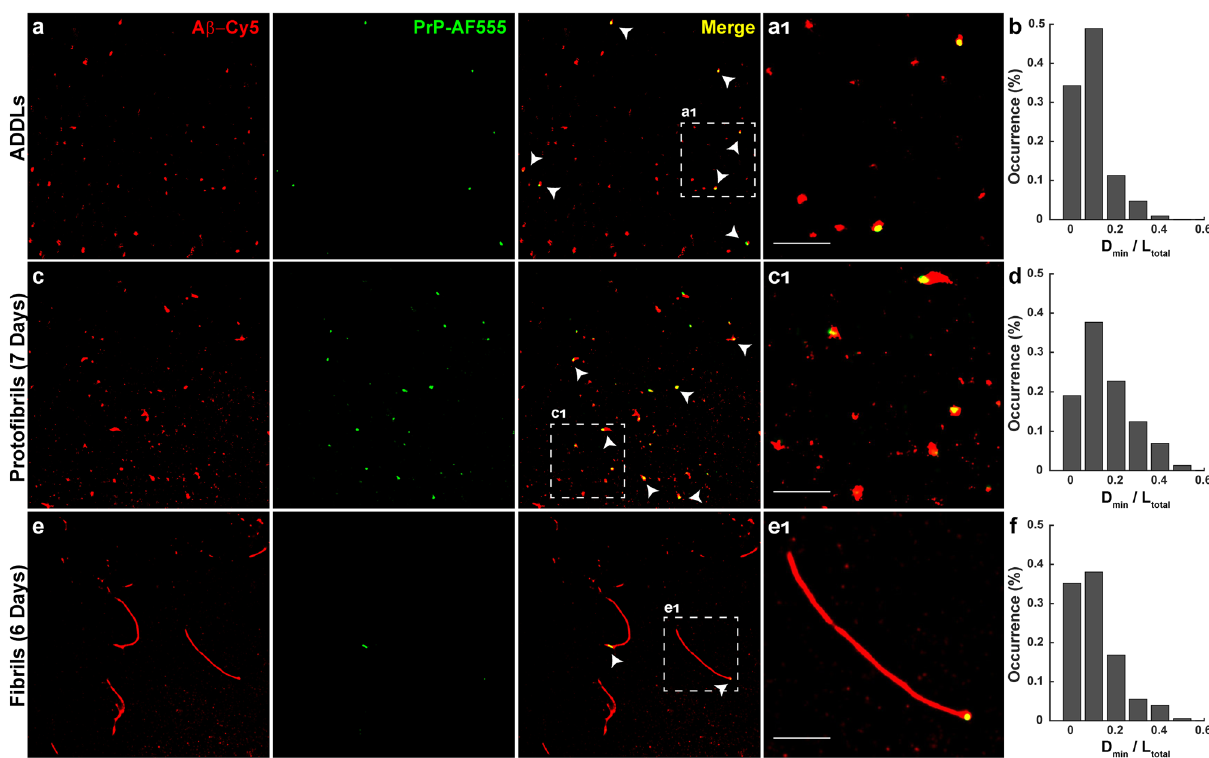
Fig. 5 Localization of PrP on neurotoxic A β assemblies. Pre-formed ADDLs ( a ), proto fi brils ( c ), and fi brils ( e ) (all at 20 µ M monomer-equivalent concentration) were incubated with 0.5 µ M PrP-AF555 and then imaged by dSTORM. Panels a 1 , c 1 , and e 1 show boxed areas in ( a , c , e ), respectively, at higher magni fi cation. Scale bars are 1 µ m. Histograms ( b , d , f ) show the distribution of D min / L total values, calculated as in Fig. 4, for ADDLs, proto fi brils, and fi brils, respectively. The number of analyzed SIM images in oligomer, proto fi brils, and fi brils condition are: X = 6; 10 and 18,